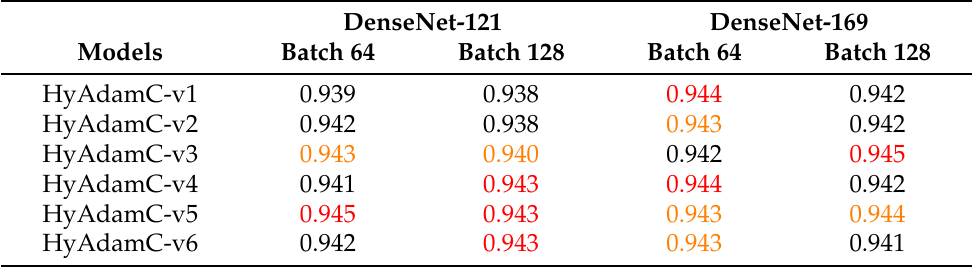
Table 5. The test accuracies of the DenseNet-121 and 169 trained by the six HyAdamC models. The first and second best results are highlighted in red and orange,